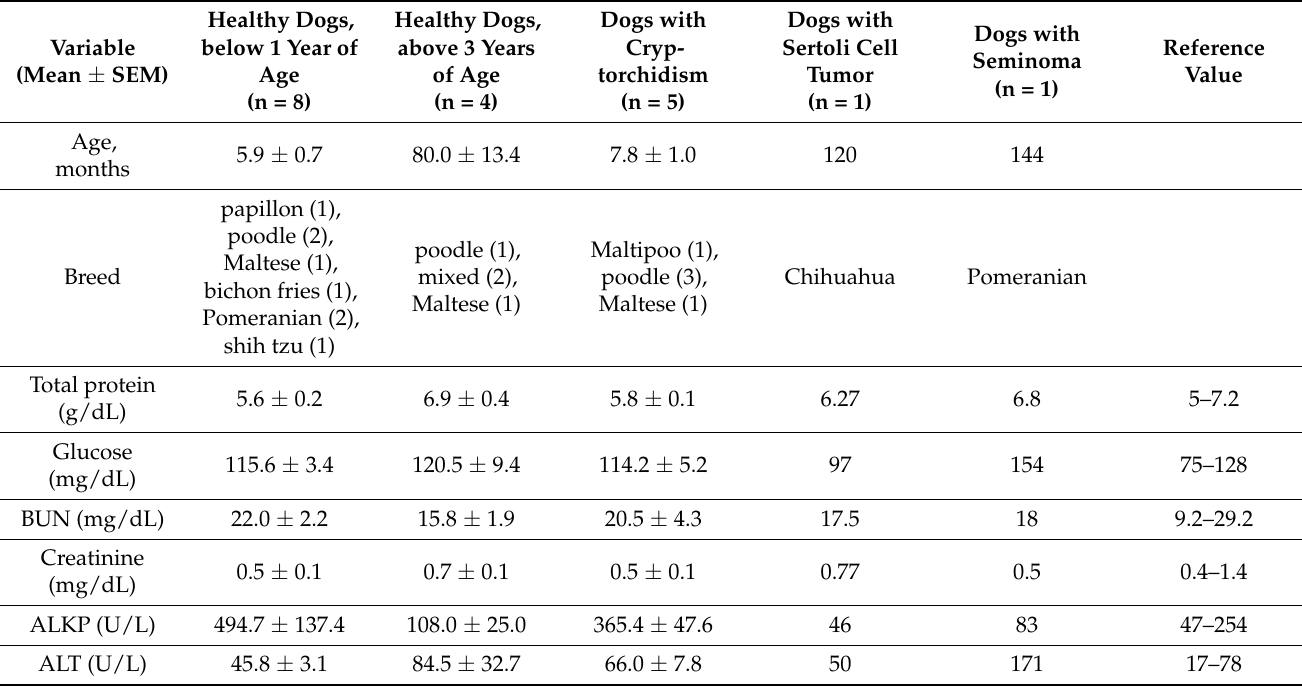
Table 1. Clinical examination of dogs included in this